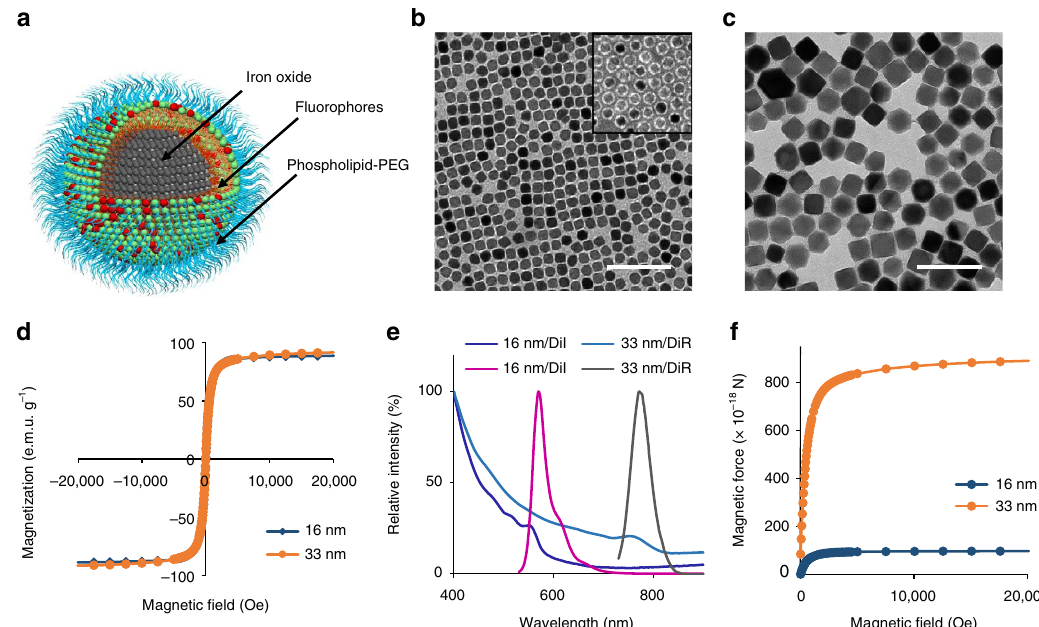
Figure 1 | Properties of magnetic iron oxide nanoparticles (MNPs). ( a ) A schematic diagram of MNP. Each MNP contains a magnetite nanocrystal and a phospholipid–PEG coating. The phospholipid layer provides anchoring sites for lipophilic fluorophores such as DiI or DiR for fluorescence tracing of MNP. ( b , c ) TEM images of 16 and 33nm diameter magnetite nanocrystals. Inset in b shows phospholipid–PEG-coated MNPs negatively stained with phosphotungstic acid. The phospholipid–PEG coating of MNPs appears as the white corona surrounding the dark nanocrystals. Scale bar, 100nm. ( d ) Magnetization curves of MNPs. ( e ) Absorption and emission spectra of 16nm MNPs labelled with DiI (16nm/DiI) and 33nm MNPs labelled with DiR (33nm/DiR), respectively. ( f ) Calculated magnetic force on individual MNPs as a function of the field strength. The gradient of the magnetic flux density was assumed to be 100Tm (cid:2) 1